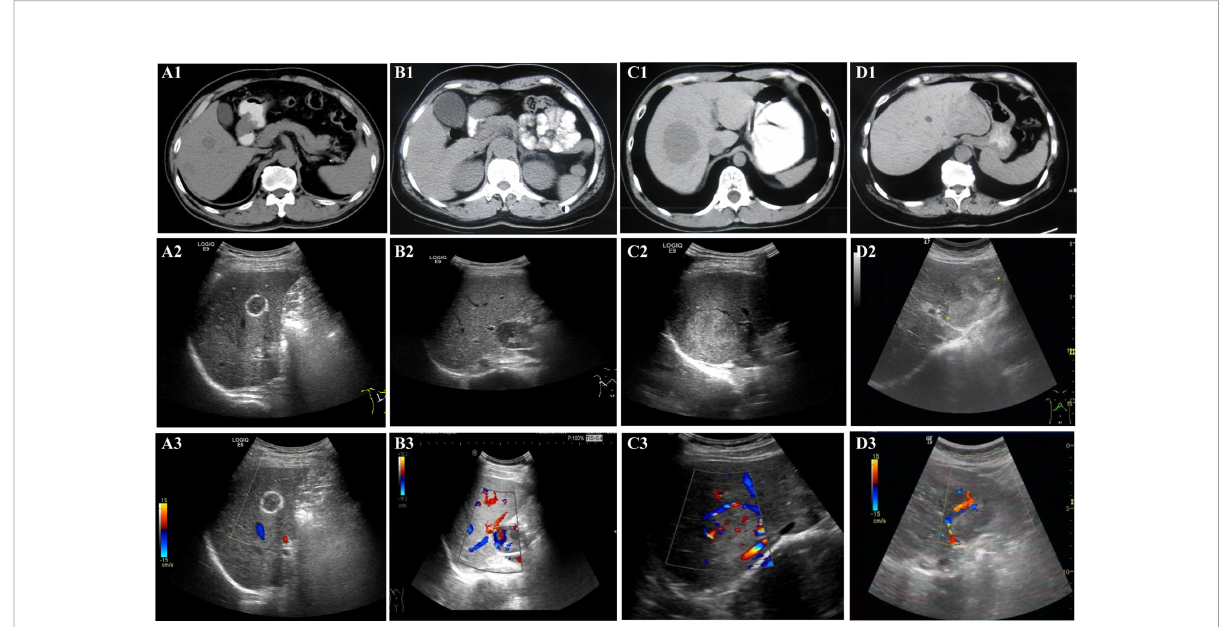
FIGURE 1 Non-enhanced imaging (CT, US, and CDFI) appearance. All patients underwent non-enhanced imaging examination, including CT, US, and CDFI. A1 (CT), A2 (US), and A3 (CDFI) are images of lesions in the patient 10. B1 (CT), B2 (US), and B3 (CDFI) are images of lesions in the patient 2. C1 (CT), C2 (US), and C3 (CDFI) are images of lesions in the patient 1. D1 (CT), D2 (US), and D3 (CDFI) are images of lesions in patient 4. For CT, (A1, B1, C1, and D1) : CT scans showed that all lesions were hypodense. For US, (A2) : US showed the lesion with hyper-echoic ring around and iso-echo inside, lateral shadow, clear boundary and regular shape. (B2) : US showed hypoechoic lesions with clear boundary and regular shape; (C2) : US showed hyperechoic lesion with clear boundary and regular shape; (D2) : US showed that the lesion were heterogeneously hyper-echoic, unclear boundary and irregular shape. For CDFI, (A3) : CDFI showed no obvious blood fl ow signal inside and around the lesion; (B3, C3, D3) : CDFI showed that there were large blood vessels and blood fl ow signals inside the